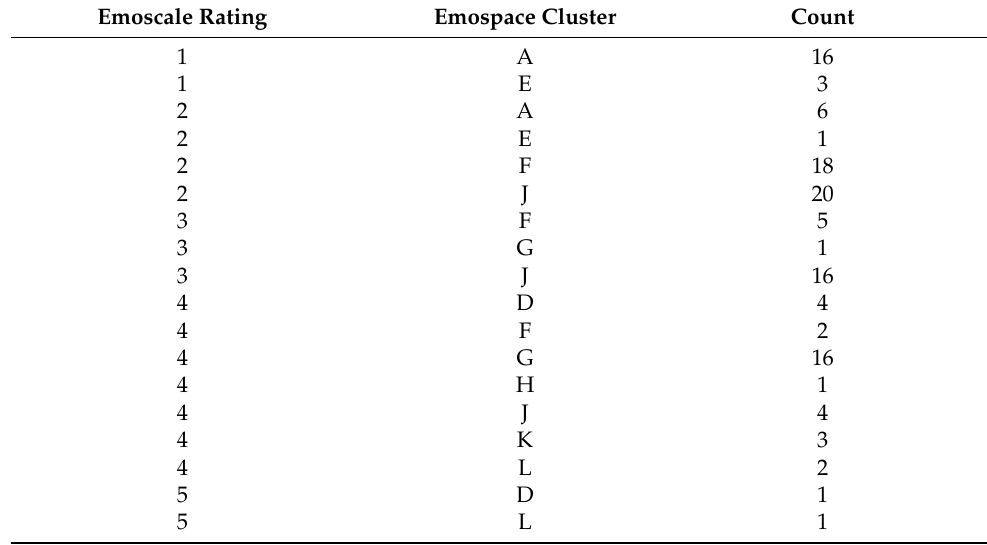
Table A1. The frequency of emoscale ratings and emospace clusters